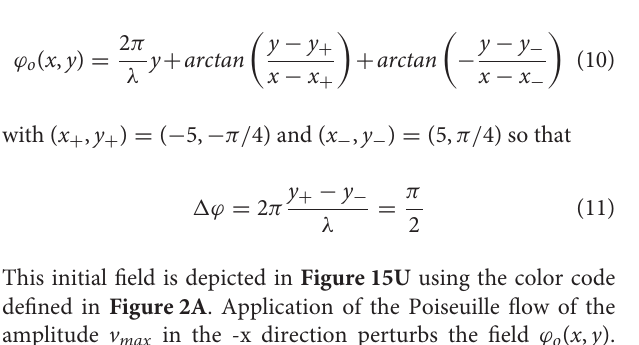
Frontiers in Physics |